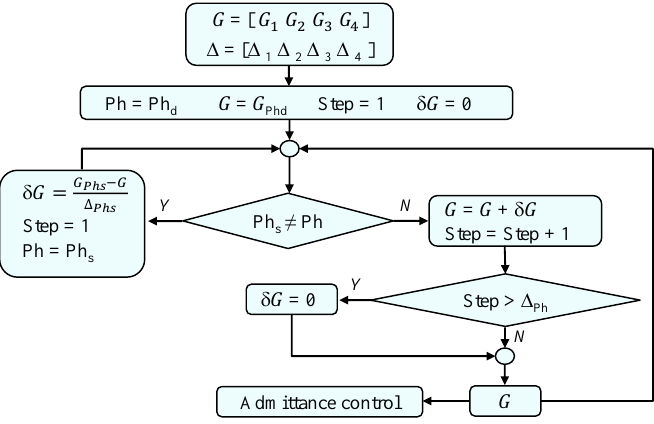
Figure 4. Flowchart of the algorithm used to generate the pattern G , where Phs is the output of the gait phase detector, and Phd is the default phase (recommended sub-phase